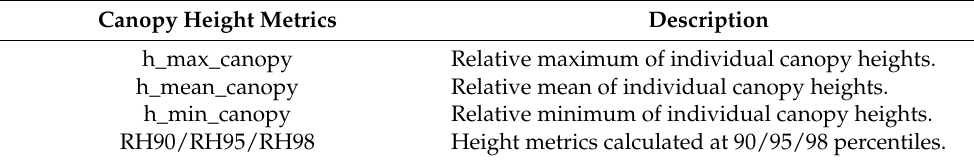
Height metrics calculated at 90/95/98